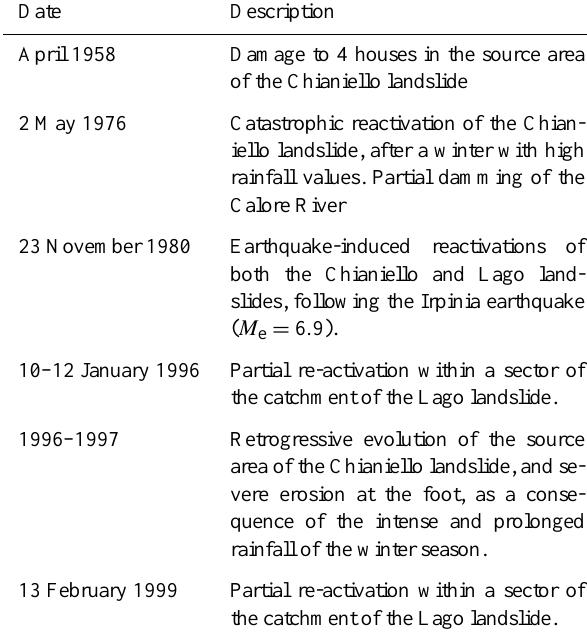
Table 1. Known dates of (re)activation for the Chianiello and Lago landslides.